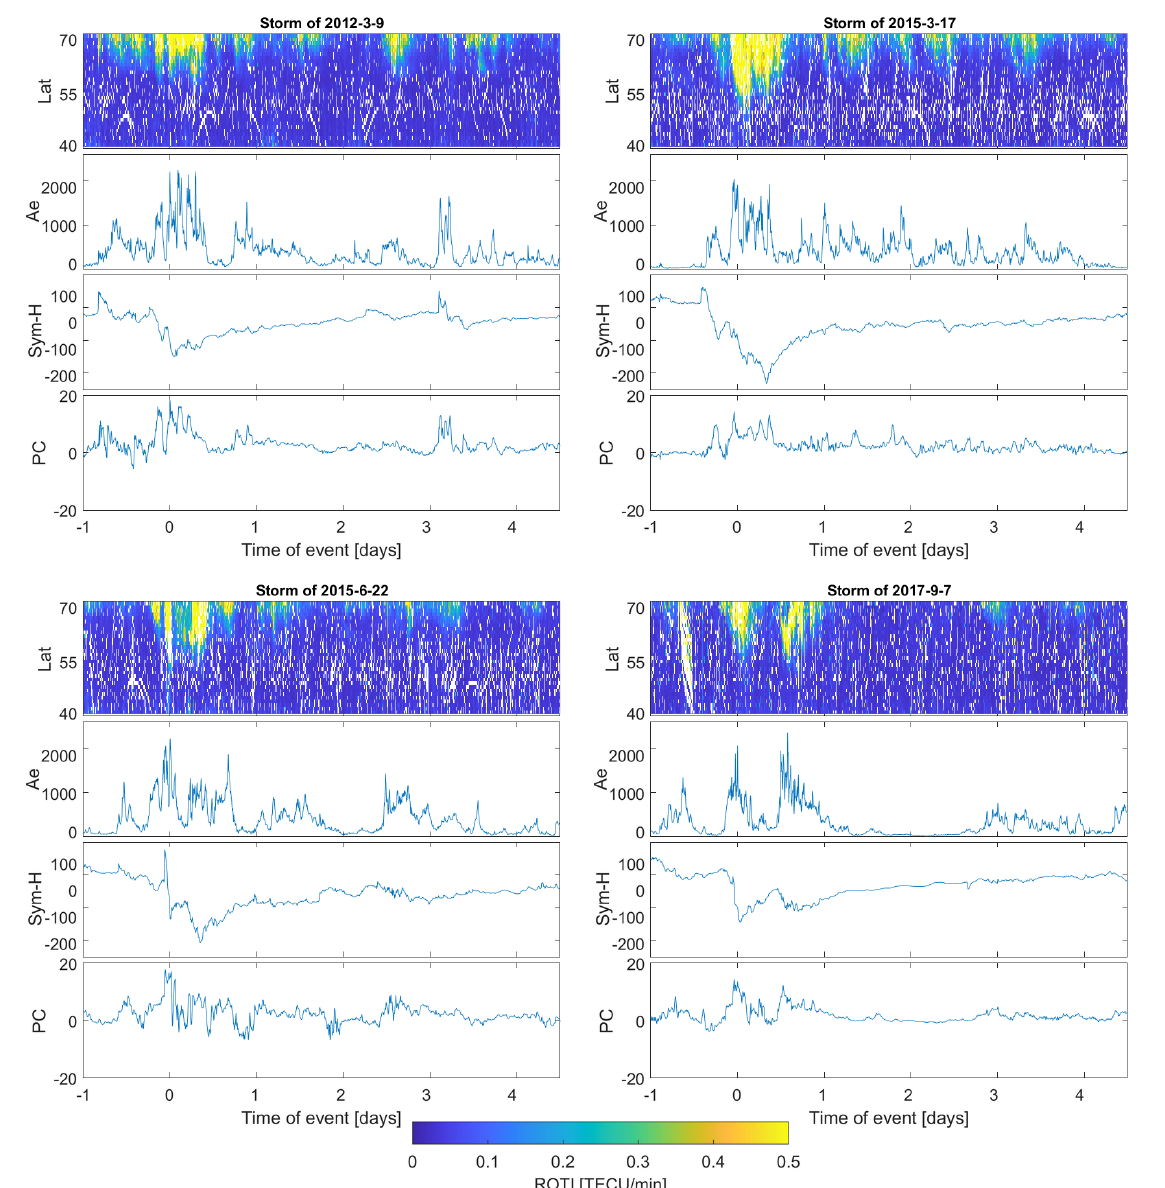
Figure 2. ROTI two − dimensional time series for severe geomagnetic storms (9 March 2012, 17 March 2015, 22 June 2015 and 7 September 2017) compared with Ae, Sym-H and PC indices